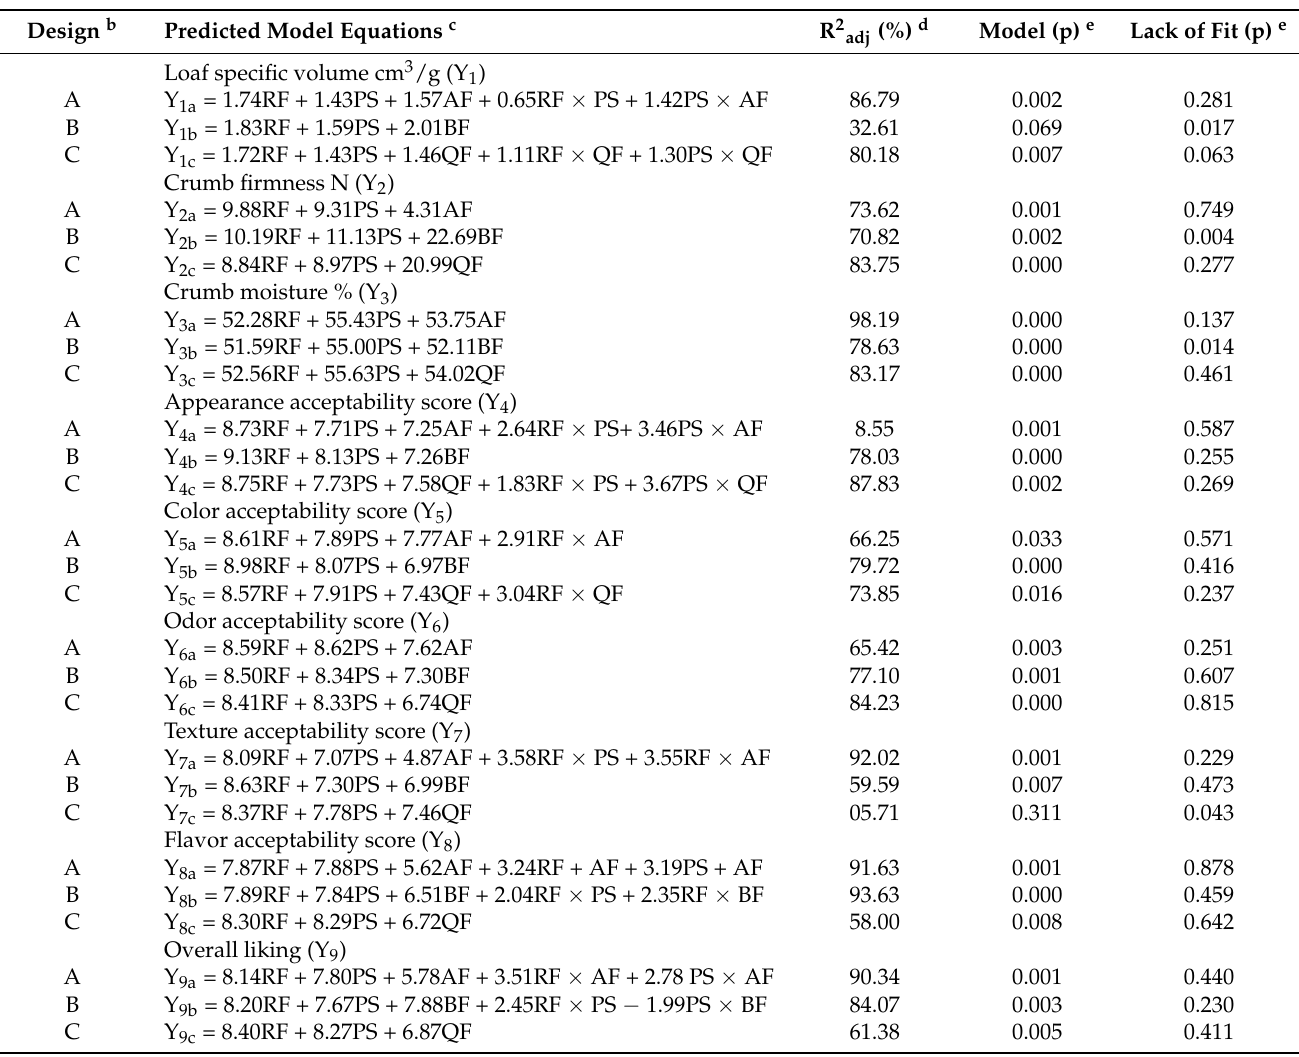
Table 1. Predicted model equations for the three mixture designs indicating the effect of each mixture component a and their interactions on the physical properties and acceptability scores of the gluten-free